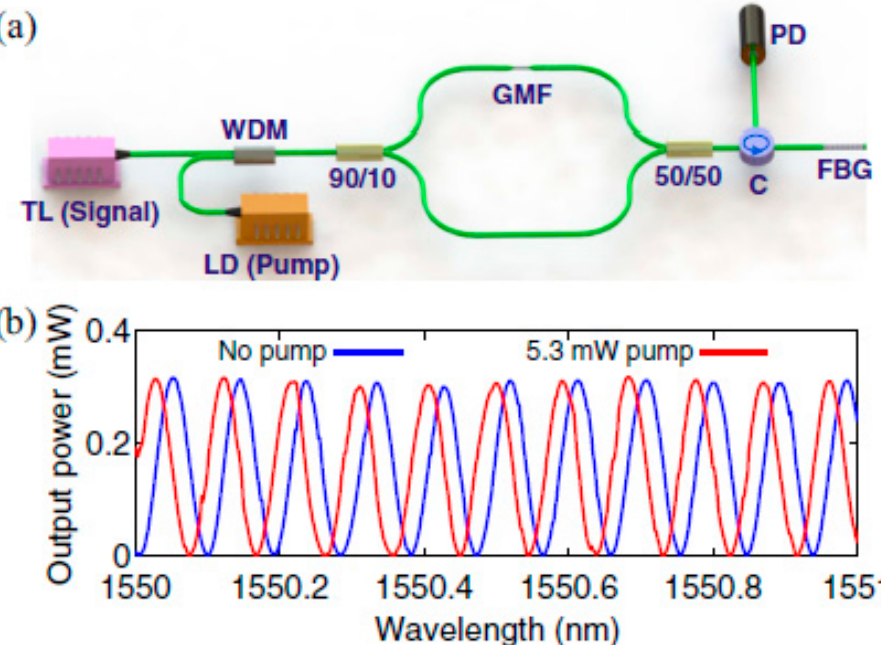
Figure 12. All-optical phase modulation based on graphene microfiber. ( a ) Schematic of the exper- imental setup for measuring the phase shift in GMF, ( b ) Measured interference fringes with and without pump [110]. Copyright 2017, The Optical